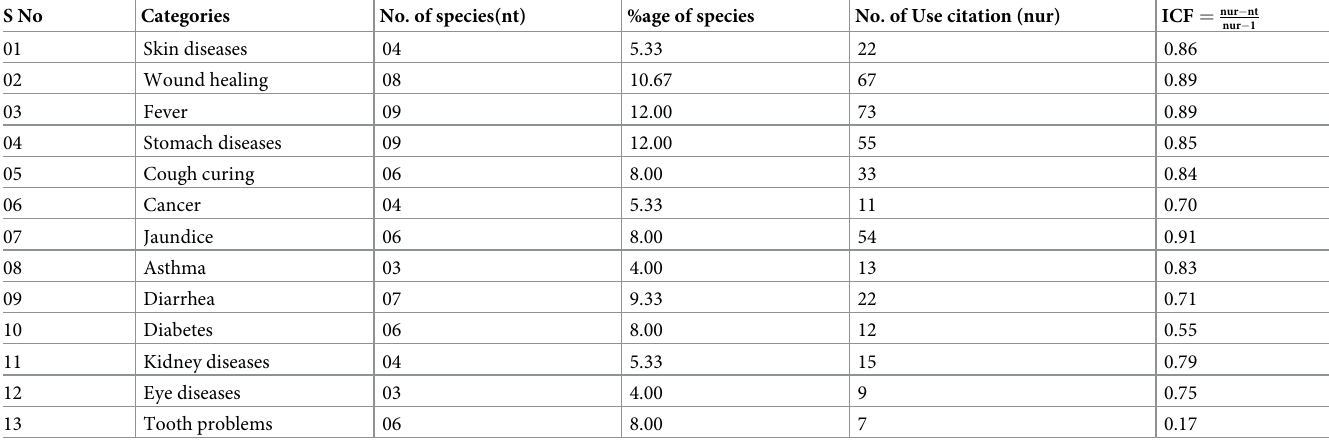
Table 3. ICF value of ethnomedicinal uses of trees of Shiwalik mountaineous range of District Bhimber AJK,